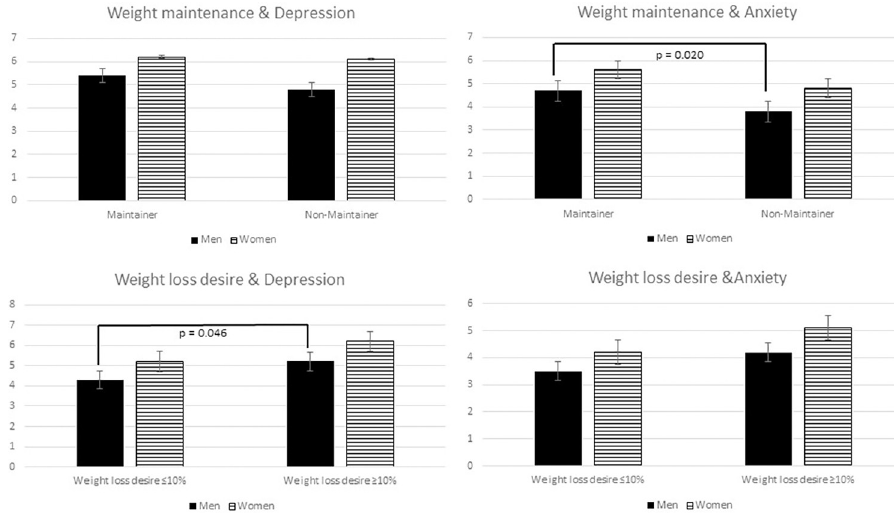
Fig 2. Weight maintenance after greatest weight loss and desired weight loss associated with psychological health for male and female participants (for depression: Mean PHQ-9 score, for anxiety mean GAD-7 score).